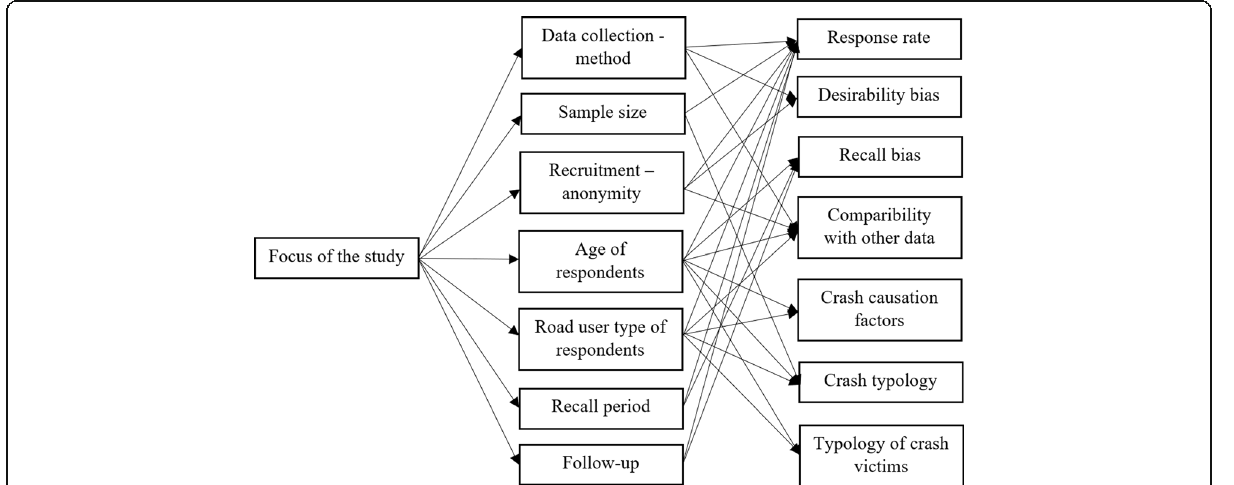
Fig. 1 The conceptual model used in the analysis of self-reporting studies